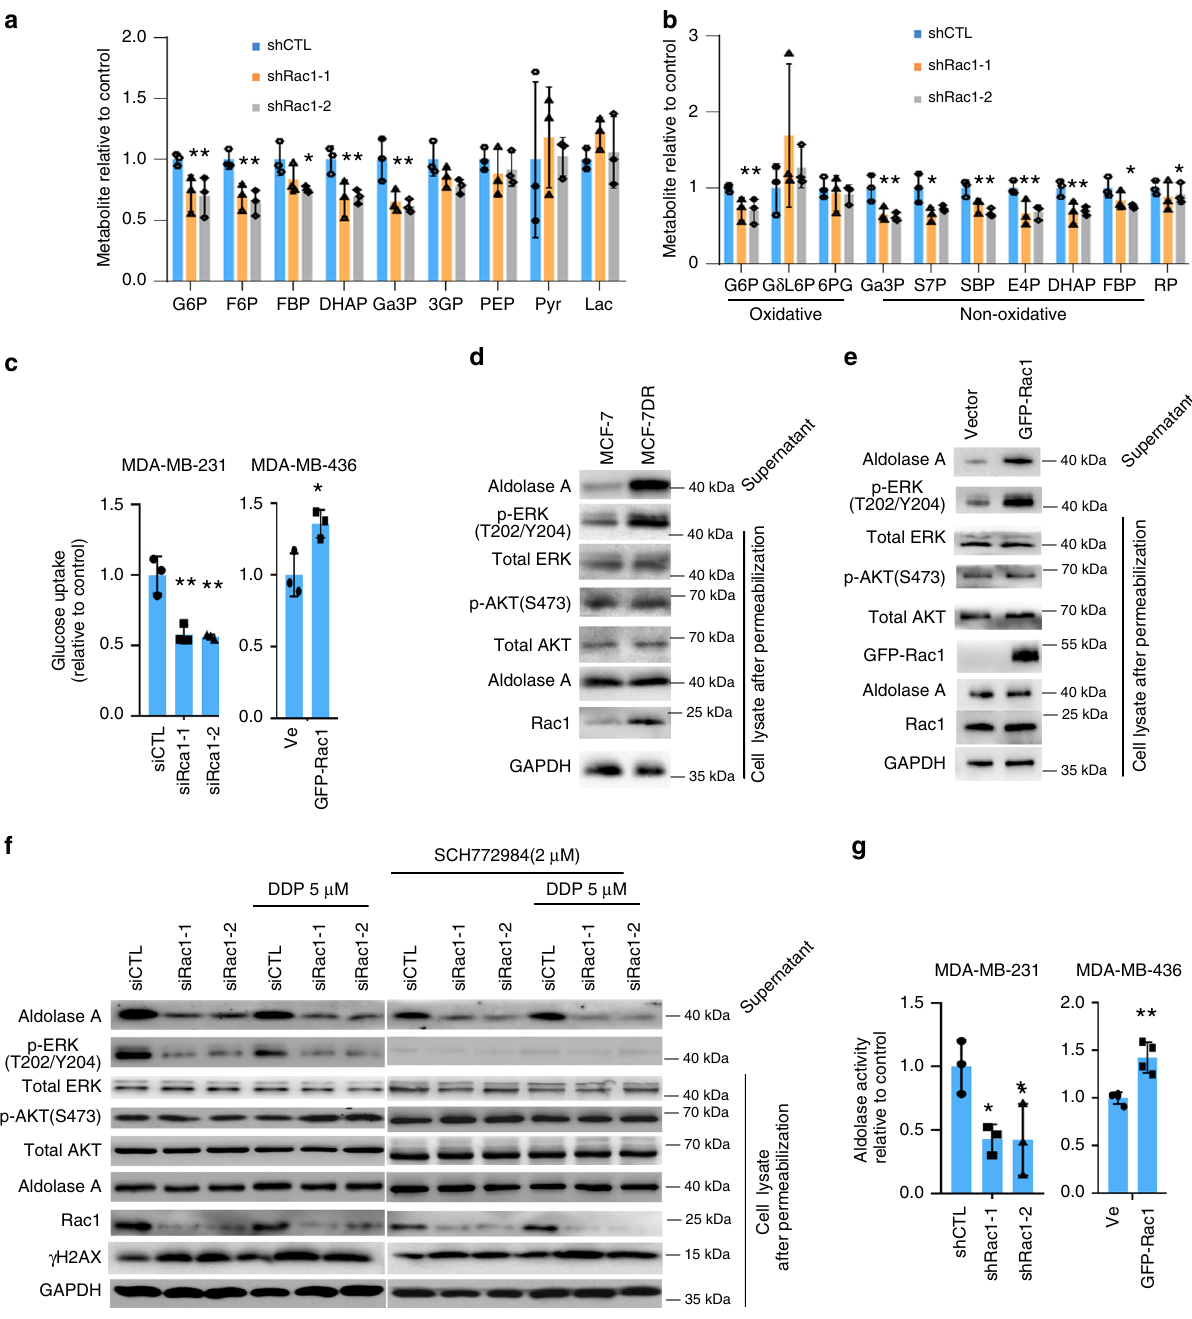
Fig. 3 Rac1 regulates glycometabolism and non-oxidative pentose phosphate pathway (PPP) via affecting aldolase activity. a , b The levels of upper glycolysis metabolites ( a ) and the glycolytic intermediates of non-oxidative PPP ( b ) decreased upon Rac1 knockdown in MDA-MB-231 cells. All metabolite levels were normalized to the vehicle control. Bar graphs represent the mean ± SD of experimental triplicates. c Glucose uptake decreased upon Rac1 knockdown and increased following Rac1 overexpression. (MDA-MB-231 siCTL vs si-1 p = 0.0079, siCTL vs si-2 p = 0.00475, MDA-MB-468 Vector vs GFP-Rac1 p = 0.0258, two-sided unpaired t -test) Bar graphs represent the mean ± SD of experimental triplicates. d Rac1 level associated with aldolase A level in supernatant and p-ERK level in cell lysate of MCF7 and MCF7R cells. The result was obtained over three independent experiments. e Rac1 overexpression increased the level of aldolase in supernatant and p-ERK in cell lysate of MDA-MB-436 cells. The result was obtained over three independent experiments. f Rac1 knockdown but not Erk inhibition reduced the level of aldolase in supernatant of MDA-MB-231 cells. ERK inhibitor SCH772984 was used. The result was obtained over three independent experiments. g Rac1 level associated with aldolase activity in breast cancer cells. (MDA-MB-231 siCTL vs si-1 p = 0.0145, siCTL vs si-2 p = 0.0469, MDA-MB-436 Vector vs GFP-Rac1 p = 0.0026, two-sided unpaired t -test). Bar graphs represent the mean ± SD of experimental triplicates. * p < 0.05, ** p < 0.01, and *** p < 0.001. Source data are provided as a Source Data fi